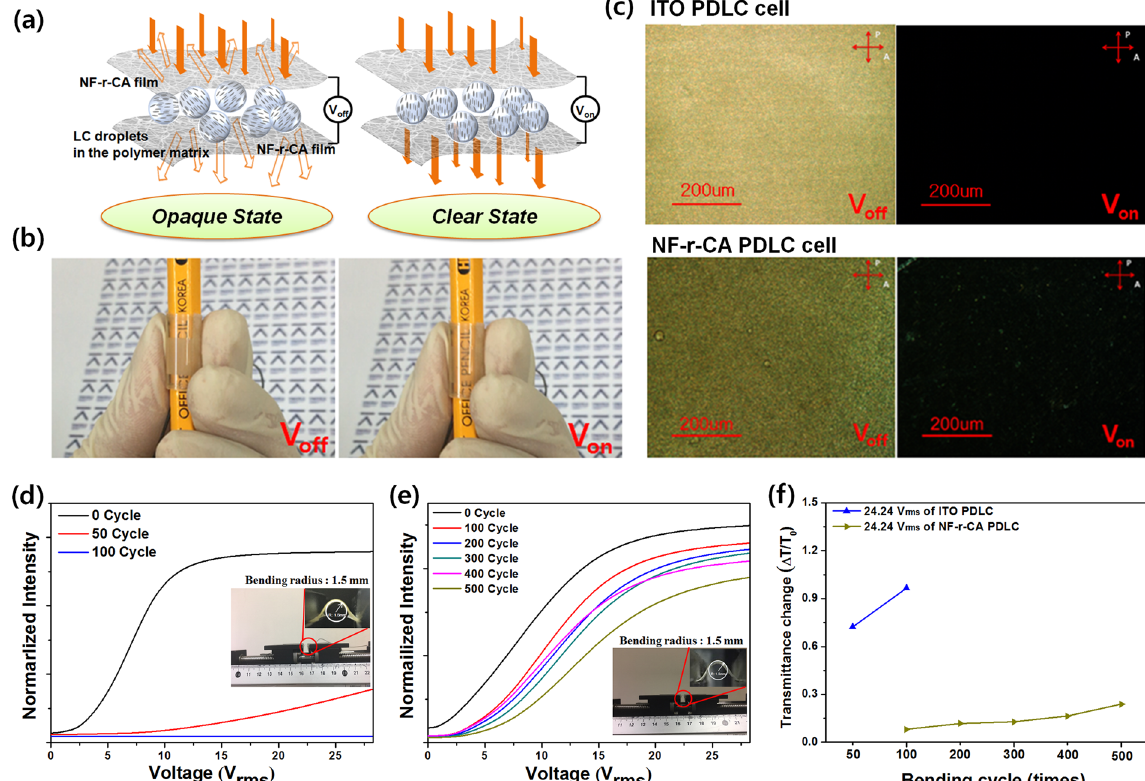
Figure 3. Comparison of PDLC films based on ITO and NF45-r-CA electrodes. ( a ) Schematic of opaque and transparent states of the NF45-r-CA based PDLC film. ( b ) Photographs of the NF45-r-CA PDLC film rolled up pencil at V off (applied voltage ~ 0 V rms ) and V on (applied voltage ~ 24.24 V rms ). ( c ) Comparison of POM images for the ITO and NF-r-CA PDLC based PDLC films at V off and V on , respectively. ( d–e ) V-T curves for foldable PDLC films prepared using both ITO ( d ) and NF45-r-CA electrodes ( e ) before and after repeated bending tests at an extreme bending radius of 1.5 mm. The inset shows the visual inspection during bending test. ( f ) Relative transmittance change of the ITO and NF-r-CA PDLC based PDLC films at the applied voltages (24.24 V rms ) after repeated bending tests (50, 100, 200, 300, 400, and 500